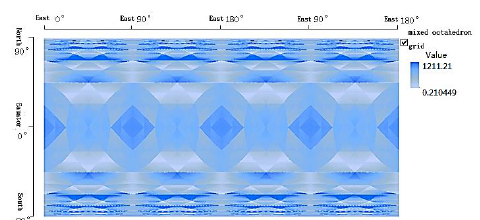
Figure 17. The electrical potential energy of the electrical potential